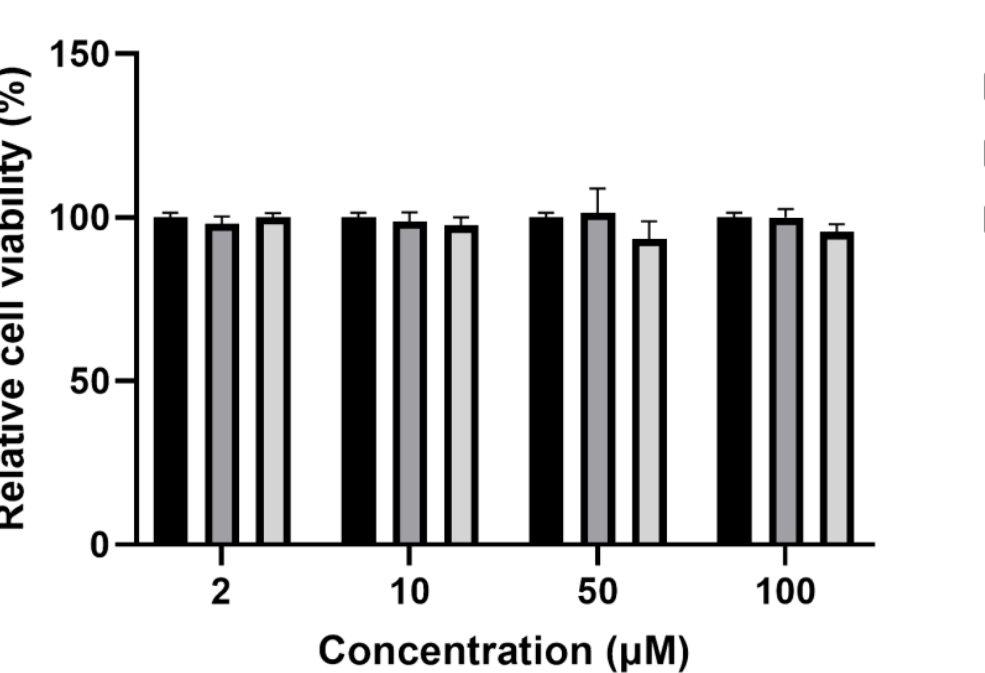
Figure 1. Cytotoxicity of theacrine and strictinin to mouse L cells. Mouse L cells were treated with theacrine or strictinin at concentrations of 2, 10, 50, and 100 μM for 24 h. MOCK was the control group. The cell viability was determined by PrestoBlue™ reagent. Data were displayed as mean ± standard deviation (S.D.) with each treatment in triplicate ( n = 3).